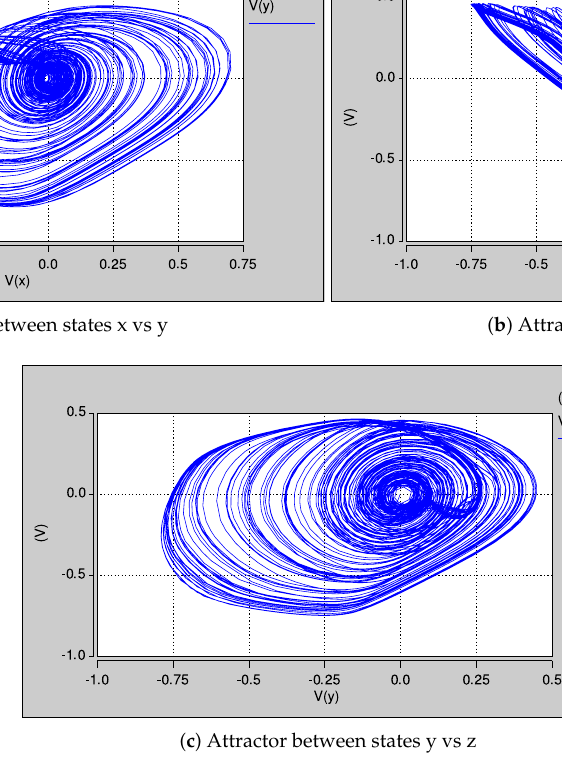
Figure 7. Portraits of the HSPICE simulation of FOCO 1 from Figure 6.